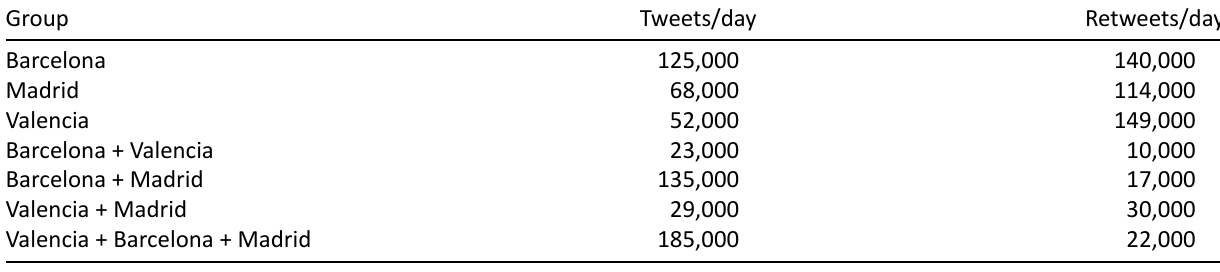
Table 4. Daily activity in groups’ accounts according to their degree of influence in different cities in the sample (in thou- sands).